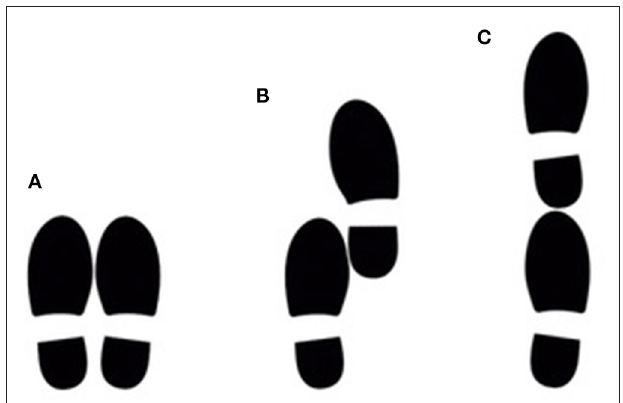
FIGURE 1 | The position of the feet during the side-by-side stance (A) , semi-tandem stance (B) and tandem stance (C) . Participants had to hold this position for 10s.